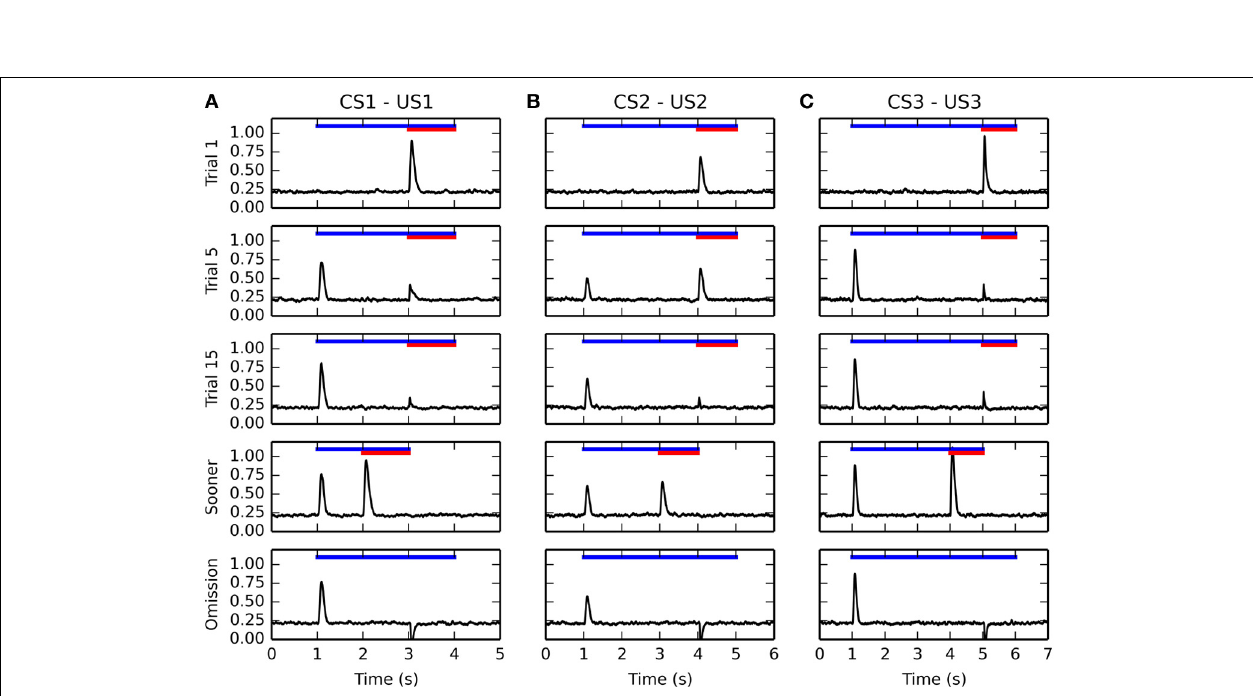
reward delivery (3, 4, and 5s after the start of the trial, respectively), and its firing rate decreases because of the adaptation of excitatory inputs in BLA, before returning to baseline when the US is removed after 1s. All other cells in BLA are not activated. The bottom row shows the activity of the same cells during the 15th trial of conditioning. They now show an increase of activity when the CS appears (1s after the start of the trial), reaching a maximum of similar amplitude as the response evoked by the US, and slowly decreasing to a baseline of about 20% of this maximal activity. When the reward is delivered, they increase their firing rate similarly a in the first trial.